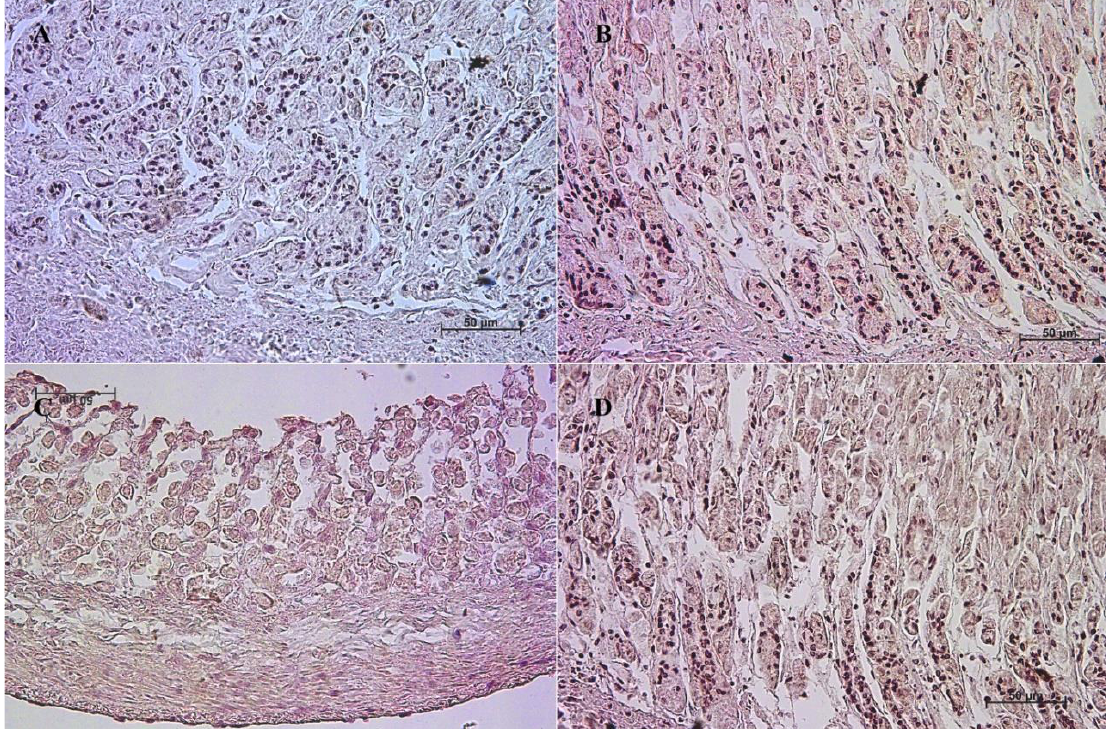
Figure 2. Negative control reaction for each cell marker (murine gastric mucosa), 40×. ( A ) gastrin, ( B ) cholecystokinin, ( C ) secretin receptors, ( D ) somatostatin.